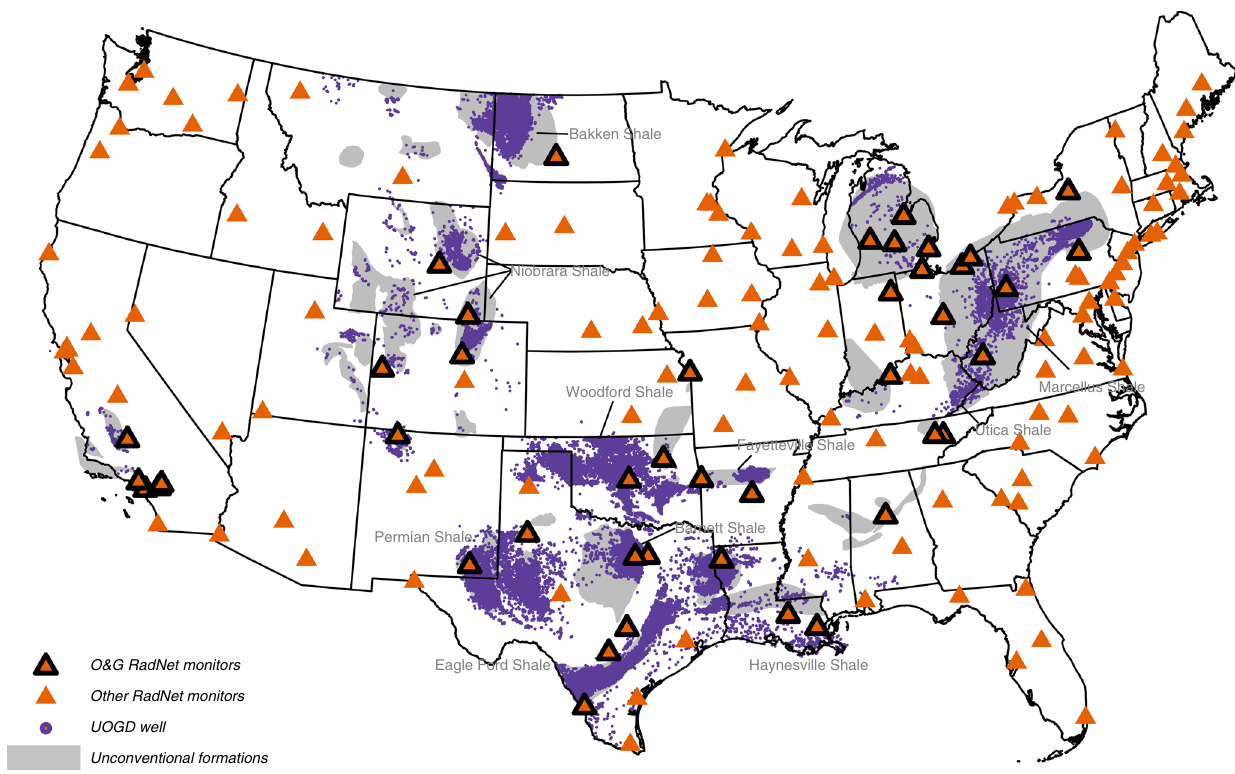
Fig. 1 The location of RadNet monitors and the UOGD wells (completed by 2017) in the continental U.S. The 157 RadNet monitors are categorized into O&G RadNet monitor (black edge) and Other RadNet monitors (no edge) based on whether a monitor is within 50 km of any O&G extractive activities.